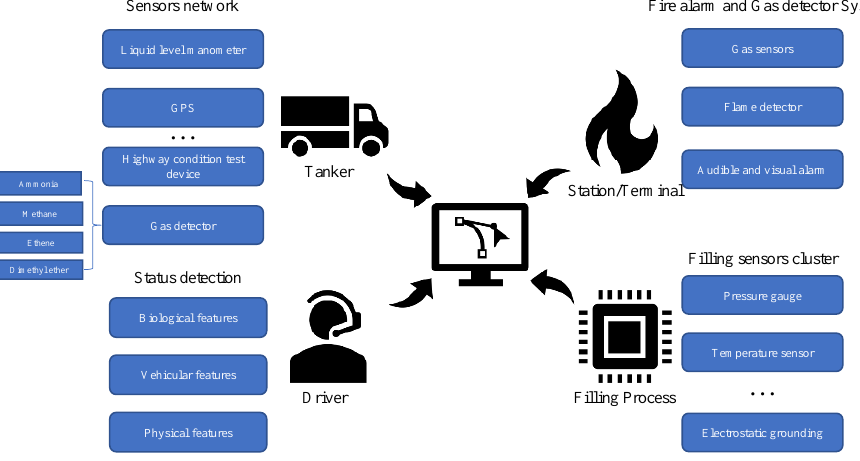
Figure 1. Overview of the hazardous chemical storage and transportation sensor